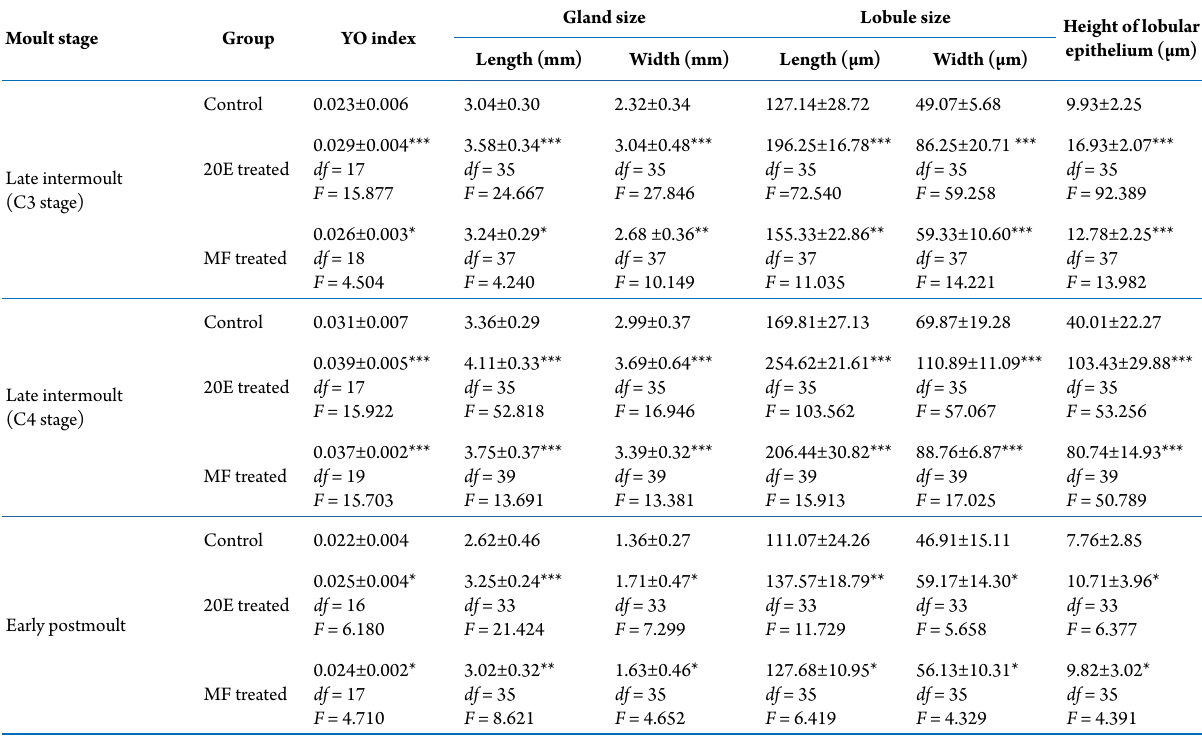
Table 1. Effect of 20E and MF administration on Y-organ (YO) index, gland and lobule size and height of lobular epithelium during late intermoult and early postmoult stages in Travancoriana schirnerae. Moult stage